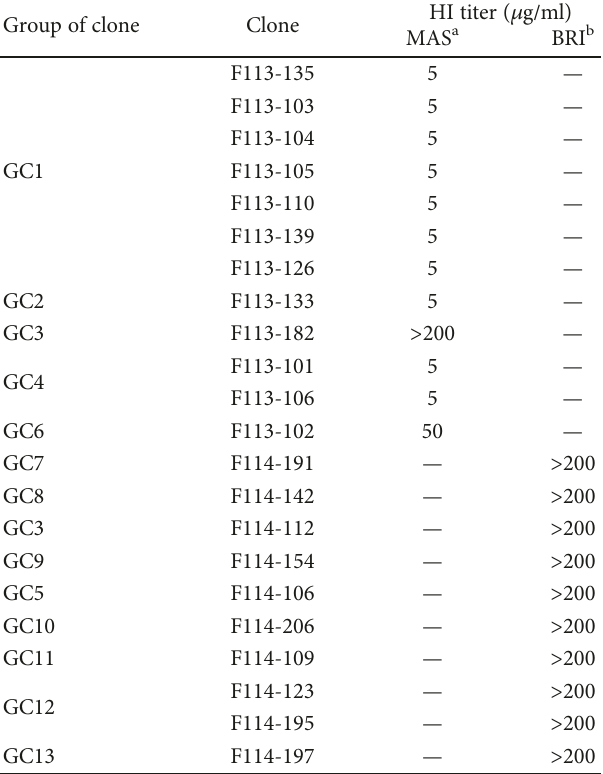
Table 2: HI activity.